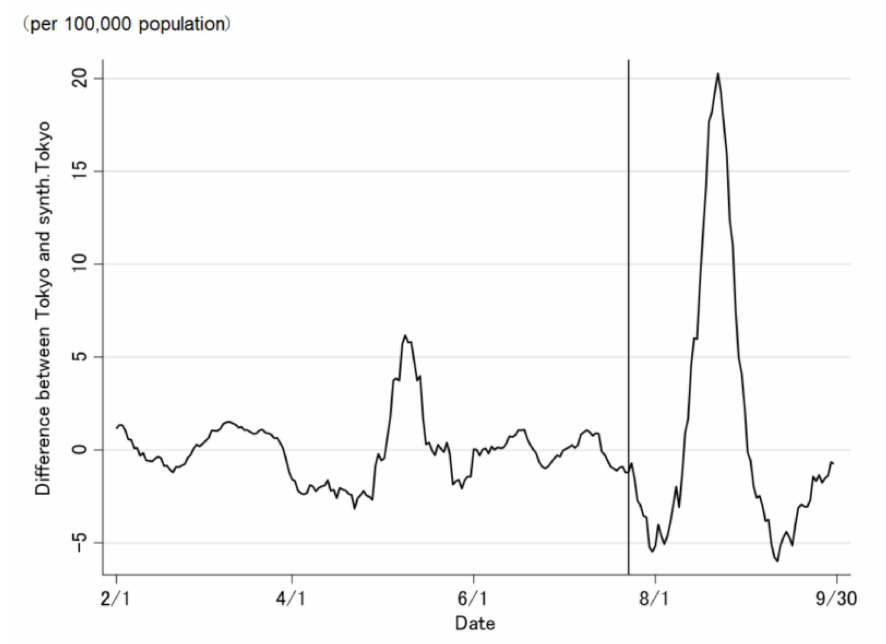
Figure 7. Difference in the daily number of newly confirmed COVID-19 cases between Tokyo and synthetic Tokyo, determined using regression